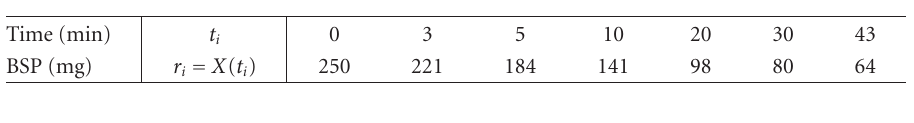
Table 1 . 2 . The amount of BSP in the